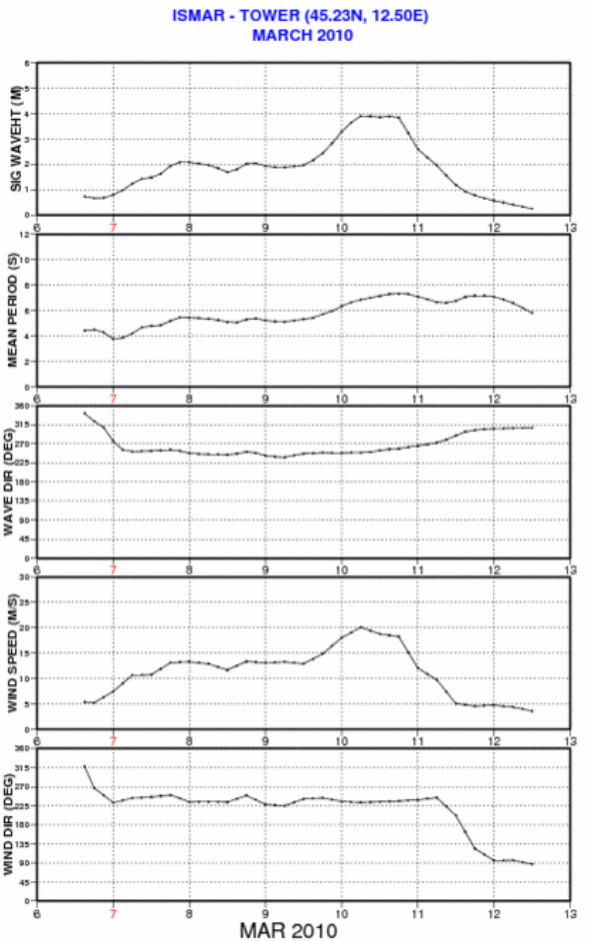
Fig. 6. Analysis of the previous 24h (till 12:00 UTC, Figure 6 – Analysis of the previous 24 hours (till 12UTC 10 March 2010) and 120 forecast of the 10 March 2010) and 120h forecast of the wind and wave conditions wind and wave conditions at the ISMAR oceanographic tower (see Figure 2). The evolution at the ISMAR oceanographic tower (see Fig. 2). The evolution cor- corresponds to the one shown in Figure 5. Flux directions are considered. responds to the one shown in Fig. 5. Flux directions are considered.